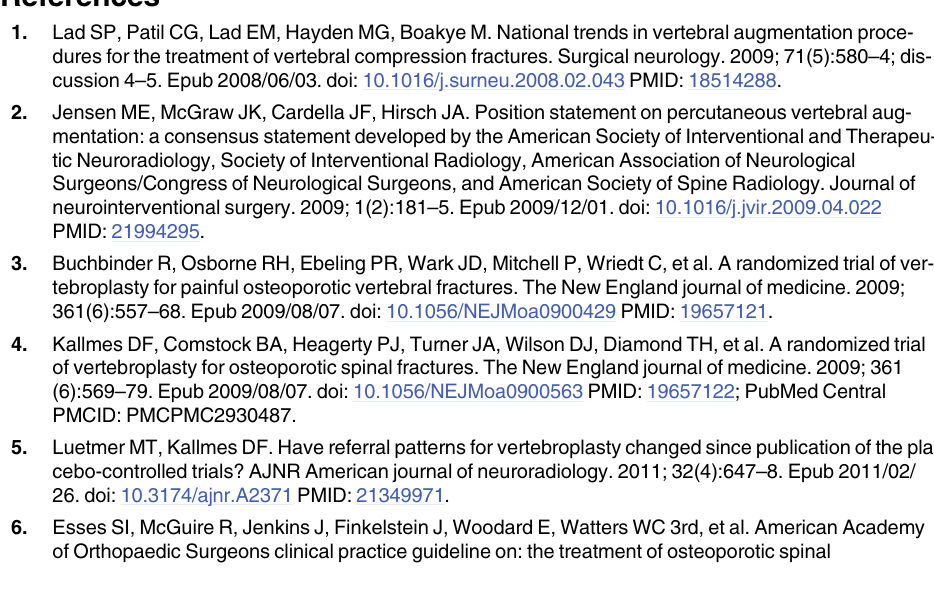
S7 Fig. Funnel plot to assess publication bias for the VAS score at early-term follow-up. The asymmetrical funnel plot means publication bias existed in this meta-analysis (TIF) S8 Fig. The trim and fill analysis model was shown with funnel plot, in which the quadratic plots were filled in random-effect Meta-analysis. S9 Fig. The chart determinated the VAS SMD change with different term point. S1 Table. Main characteristics of the identified studies pooled in the meta-analysis. S2 Table. Effect size (SMD, random Hedges ’ g) and confidence intervals according to study characteristics. S3 Table. Effect size (SMD, fixed Hedges ’ g) and confidence intervals according to study characteristics. S4 Table. Subgroup analyses of the included studies at different times by different influen- tial